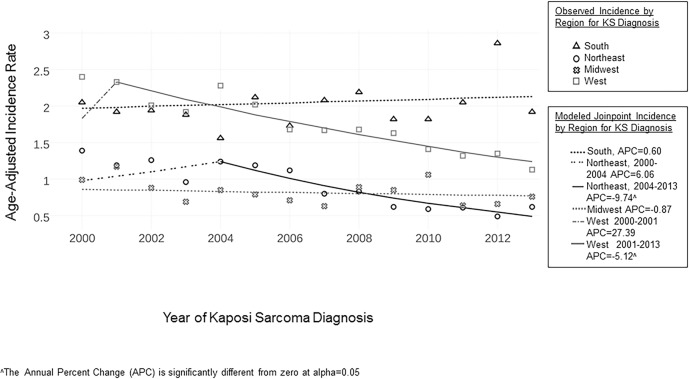
KS incidence in the U.S. by geographic region, 2000–2013.